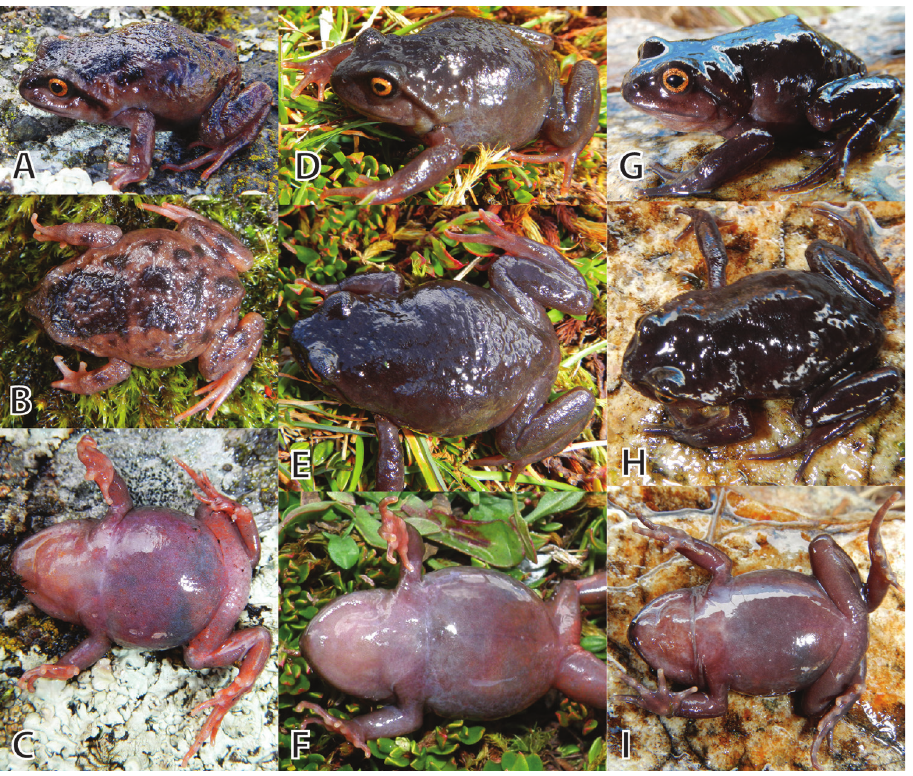
Figure 7. Variation of male paratypes of Phrynopus inti sp. n. in dorsolateral, dorsal, and ventral views. A–C (UMMZ 245220, SVL 27.4 mm), D–F (MUSM 31976, SVL 35.2 mm), G–I (MSUM 31984, SVL 35.1 mm ). Photos by E. Lehr, and by J.C. Cusi ( E